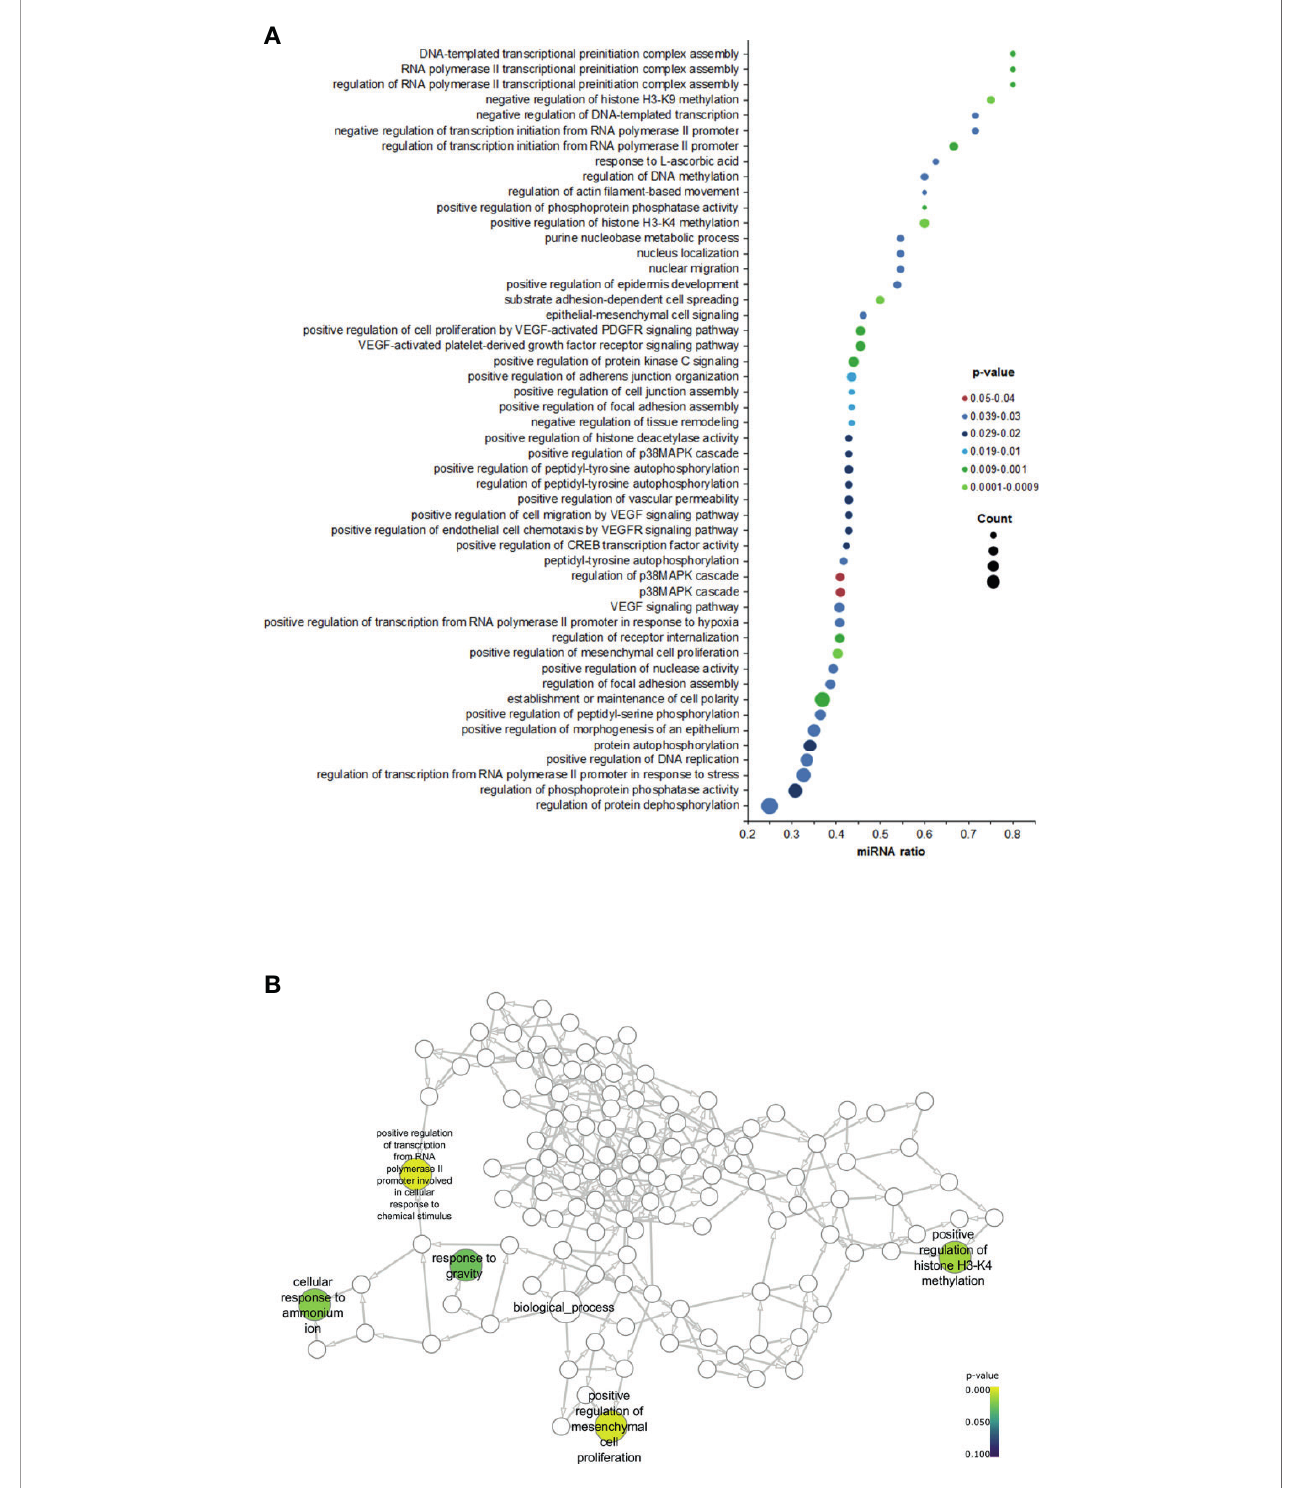
FIGURE 4 | Gene ontology (GO) enrichment analysis for the signi fi cant biological processes associated with positive SLNs. (A) Dot plot graph shows the 50 most signi fi cant biological process GO terms (y-axis) and the ratio between the number of expressed miRNAs associated to the GO term and the number of signi fi cantly differentially expressed genes associated to the GO term (x-axis). The color of the nodes indicates the p-value and the size of the nodes the number of miRNAs associated with a speci fi c GO term. (B) Neural network shows the GO terms for the biological processes associated with patients with positive